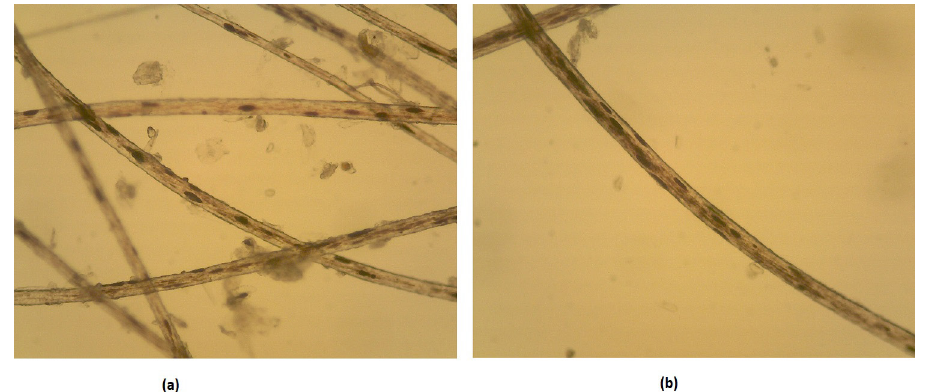
Figura 2. Agregados de Melanina observados no tricograma realizado em cão SRD diagnosticado com Alopecia por Diluição da cor.